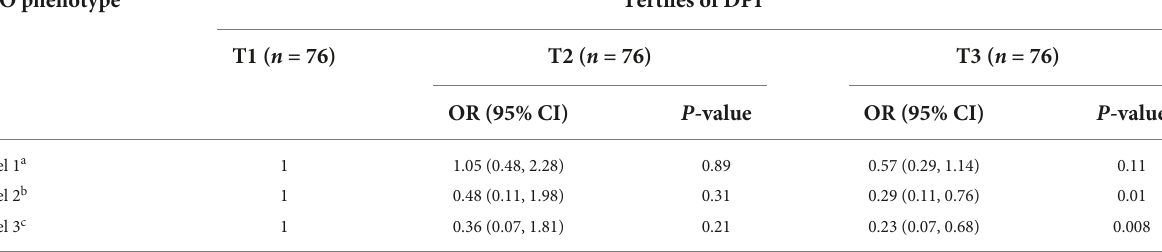
TABLE 3 Multivariate adjusted odds ratios (OR) and 95% confidence intervals (CI) for MUO phenotypes across tertiles of DPI. MUO phenotype